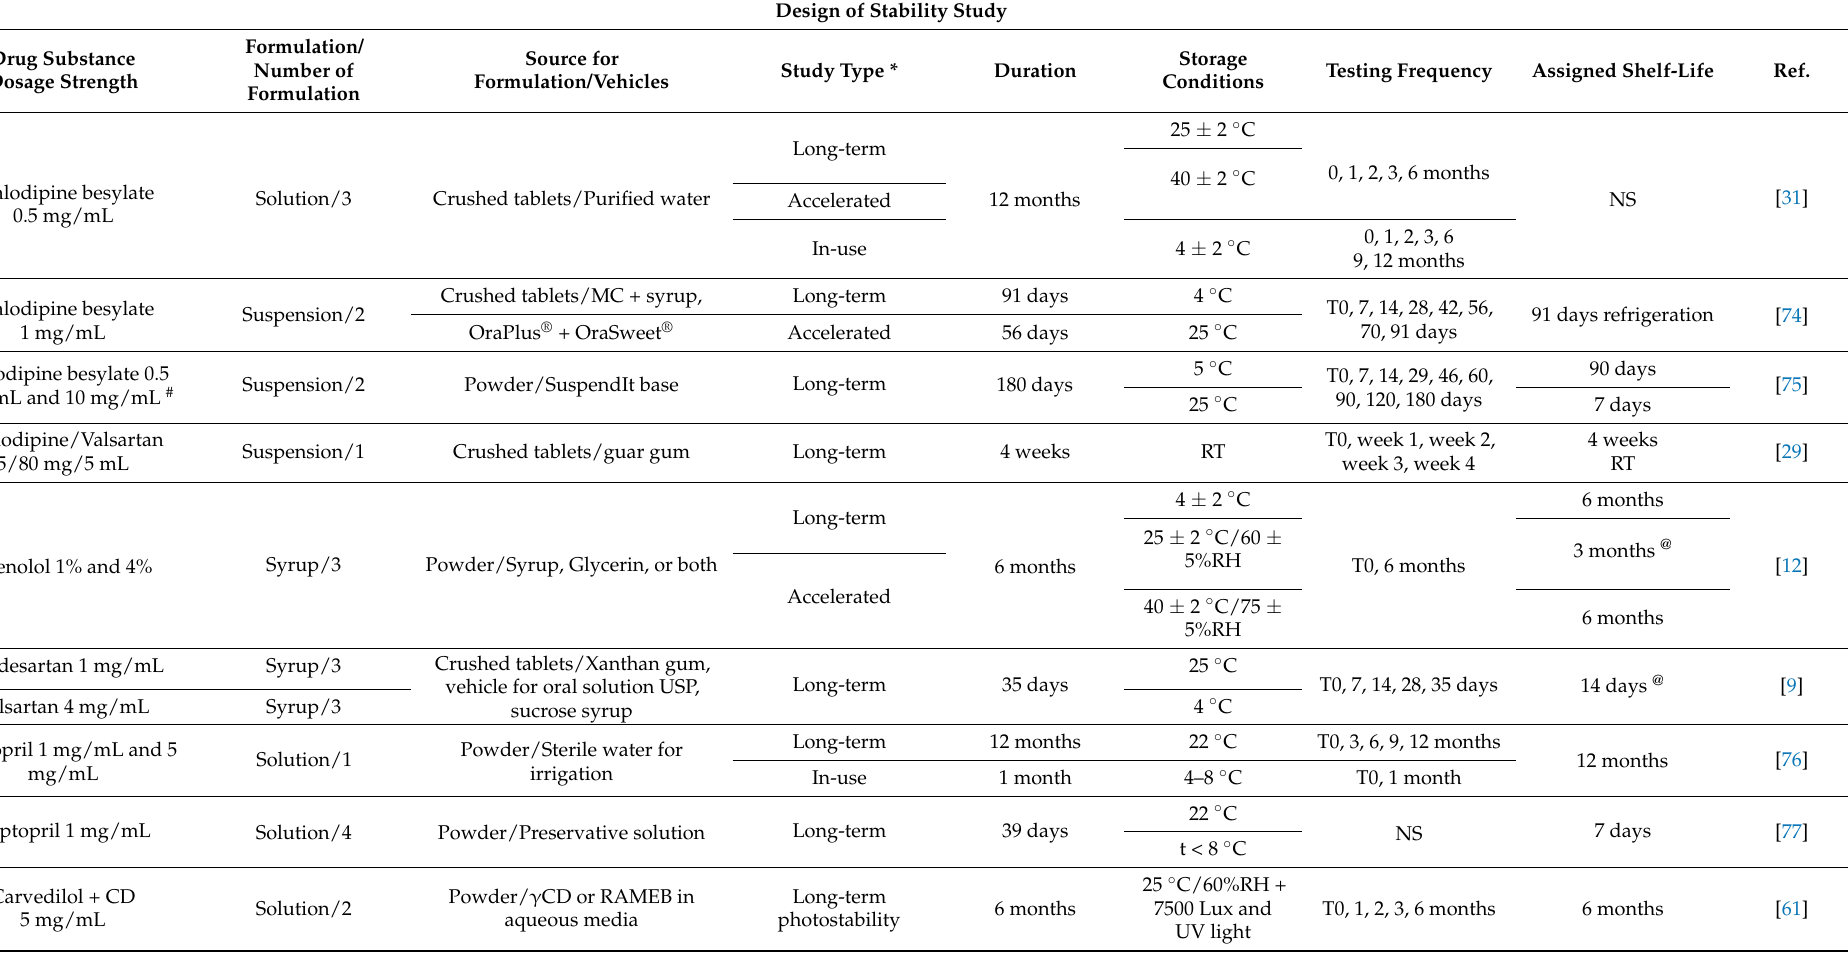
Table 3. Stability study